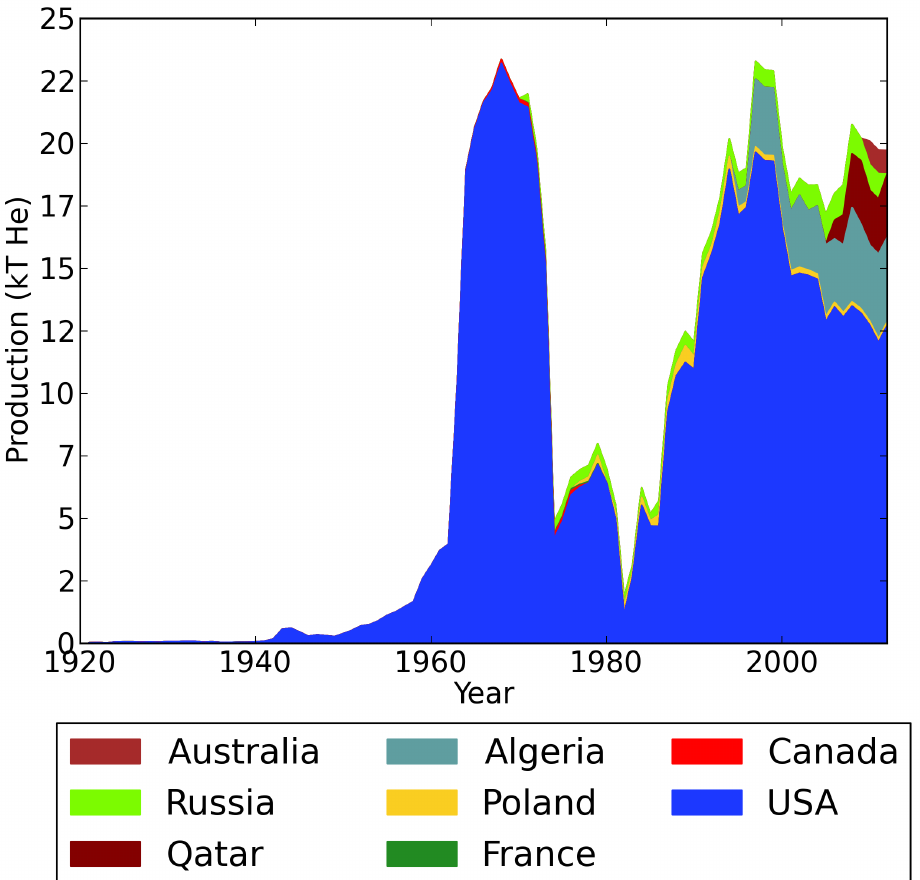
Figure 2. Helium production for the world by